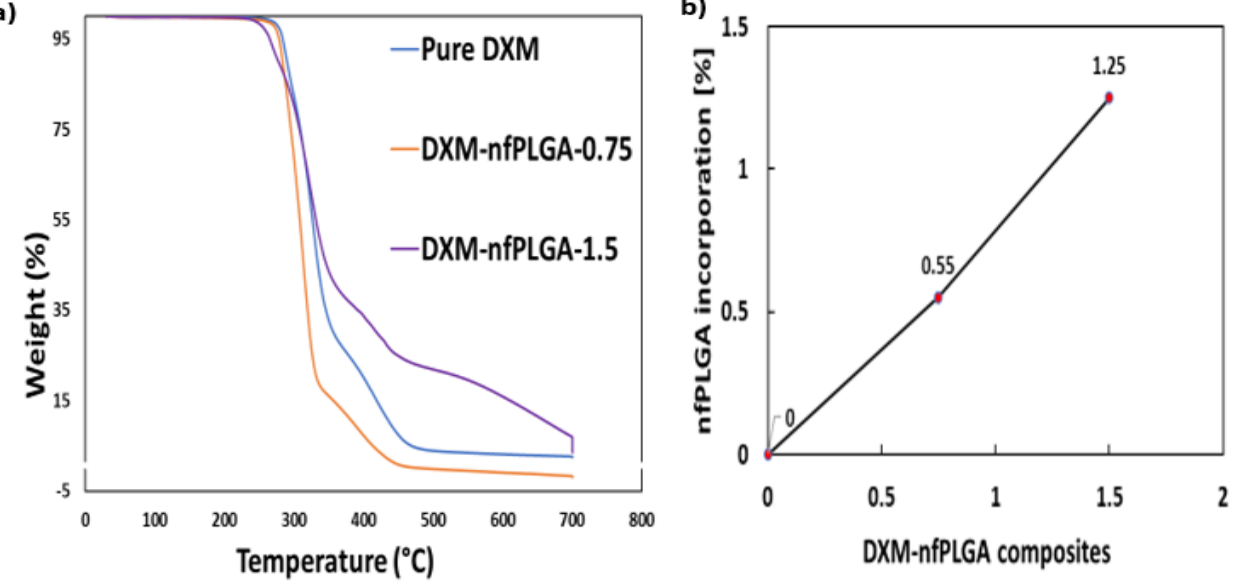
Table 2. Physicochemical properties and dissolution data related to DXM– nf PLGA composite.